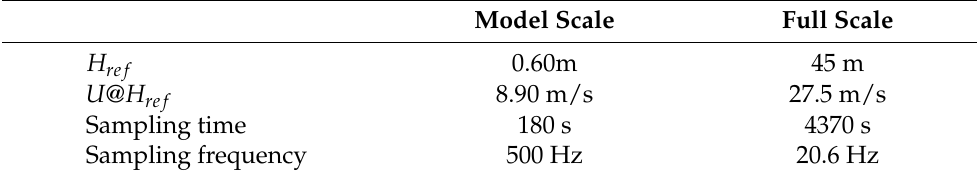
Table 1. Reference height, velocity, sampling time and frequency for the wind tunnel